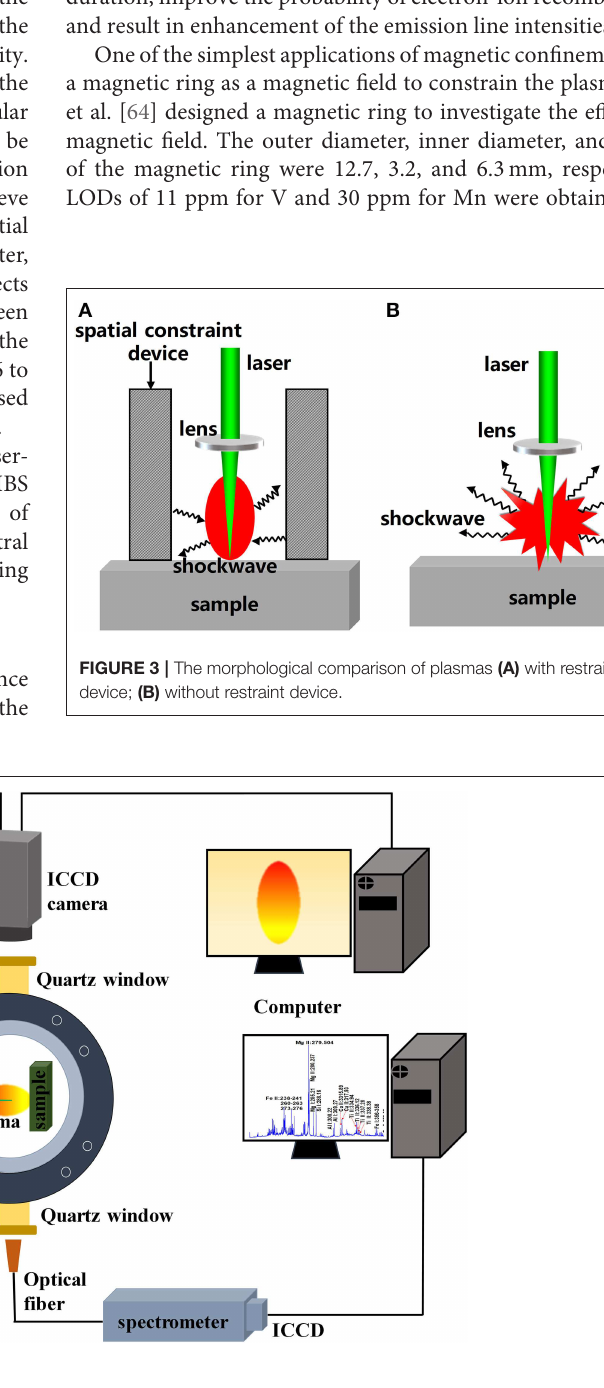
FIGURE 2 | An example of the structure of a closed air